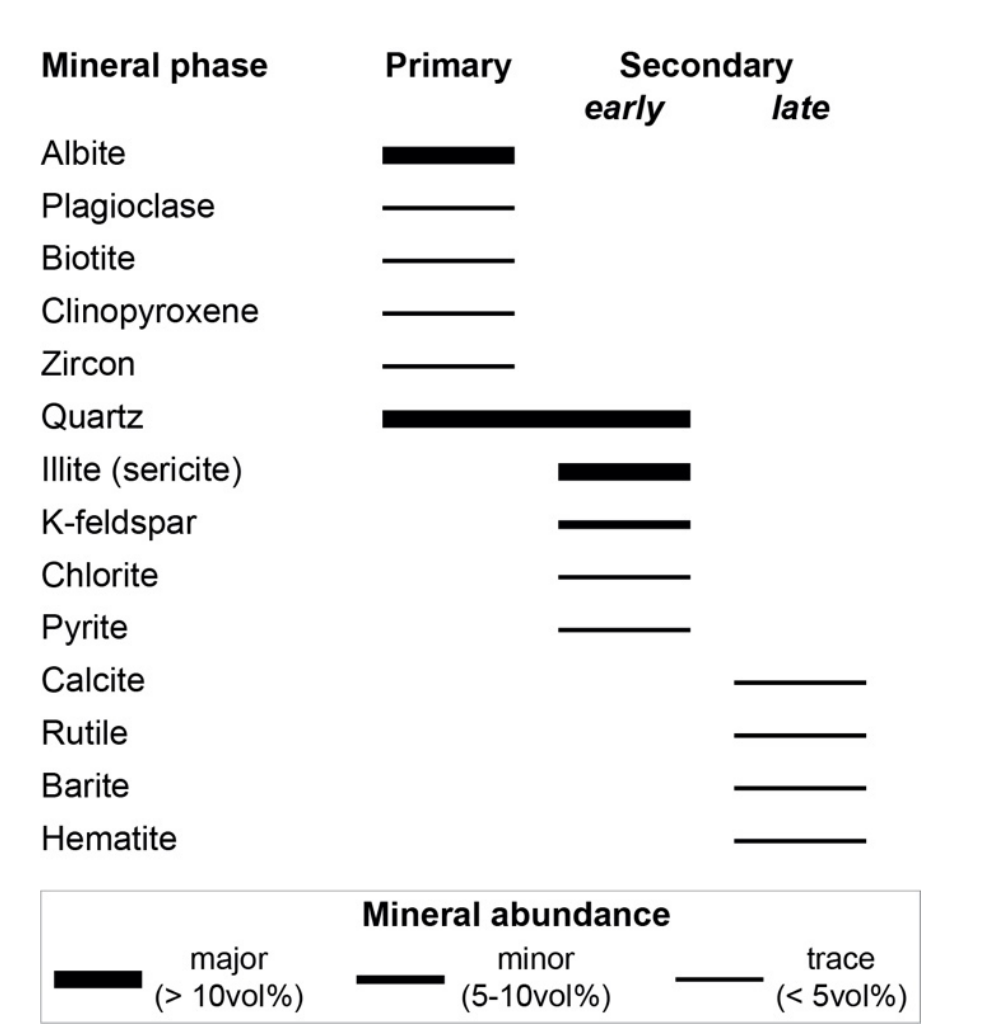
Figure 15. Primary (igneous) and secondary (alteration) minerals of altered felsic flows and their paragenesis.